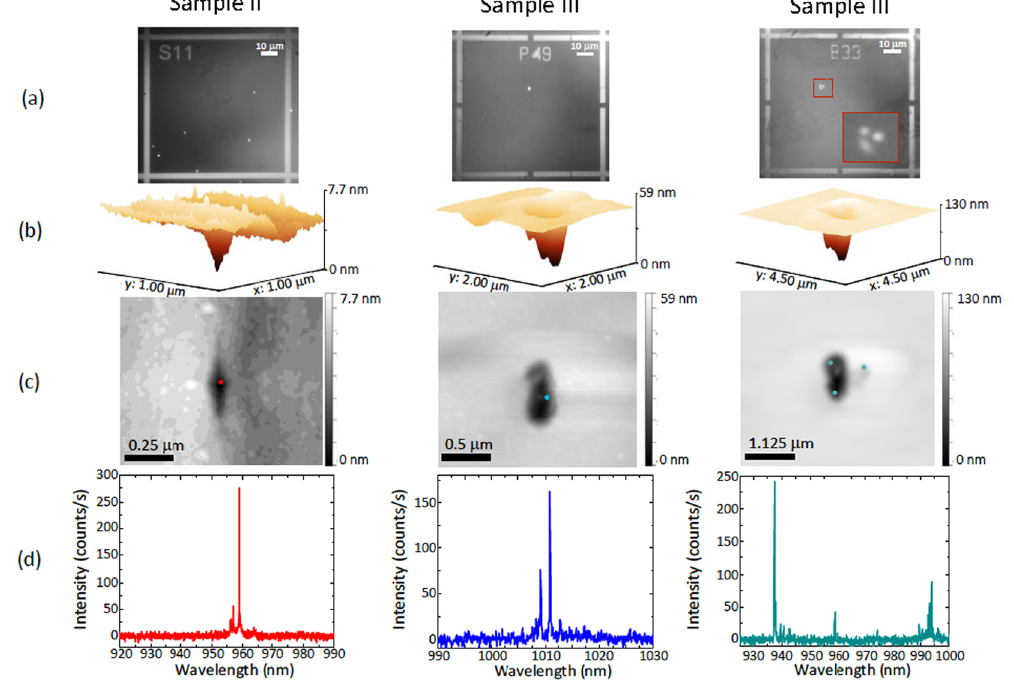
Figure 3. Examples of different morphological features observed via atomic force microscopy, correlated to quantum dot positions and their photoluminescence spectra ( a ) EMCCD images of the photoluminescence from QDs and reflected light by the alignment marks (metallic crosses), acquired by illuminating three different fields of two different samples (sample II in the first column and sample III in the second and third columns) simultaneously with both the red and near-infrared LEDs, at a temperature of 4 K. The inset in the third image represents a zoom-in of the area marked by the dashed red lines in the QD photoluminescence image. ( b ) Three-dimensional atomic force microscope images of surface features located in proximity to the QD’s emitting dipole positions, obtained from the photoluminescence images shown in panel (a) (the images are rotated 50° counterclockwise with respect to the images in panel (c)). ( c ) Two-dimensional atomic force microscope images of the surface features shown in panel (b). The colored dots represent the QD locations, as extracted from the images in panel (a). The one standard deviation uncertainties in the QD location are 47 nm (Sample II, left panel), 31 nm (Sample III, center panel), and 21 nm, 51 nm, and 48 nm (Sample III, right panel, top left, bottom left, and top right QDs, respectively). ( d ) Photoluminescence spectra collected from the QDs shown in panel (a), collected under 780 nm continuous-wave laser excitation at a temperature of 4 K, on a silicon CCD